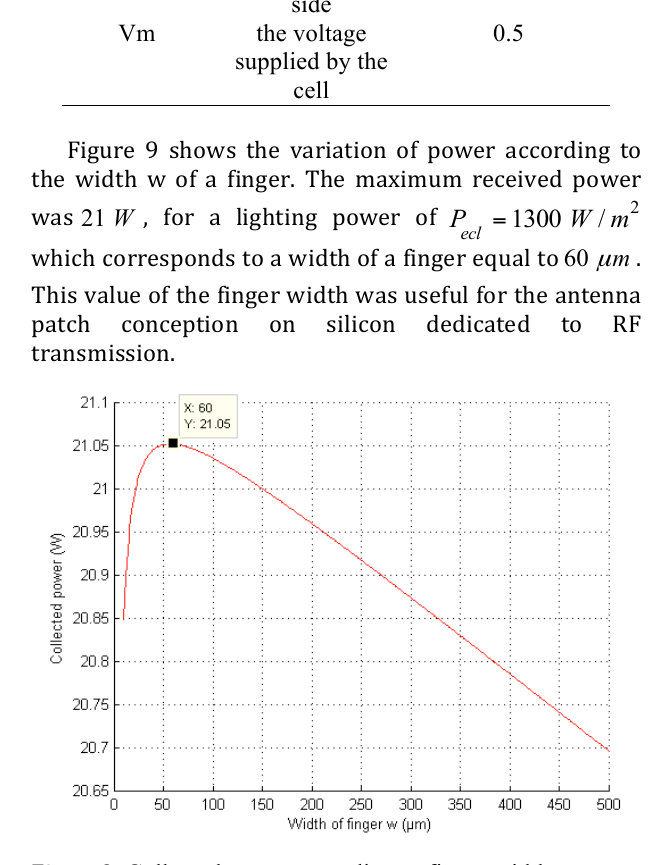
Figure9. Collected power according to finger width The optimization of the front face of the collection grid requires the right choice of the geometry of the grid and its manufacturing